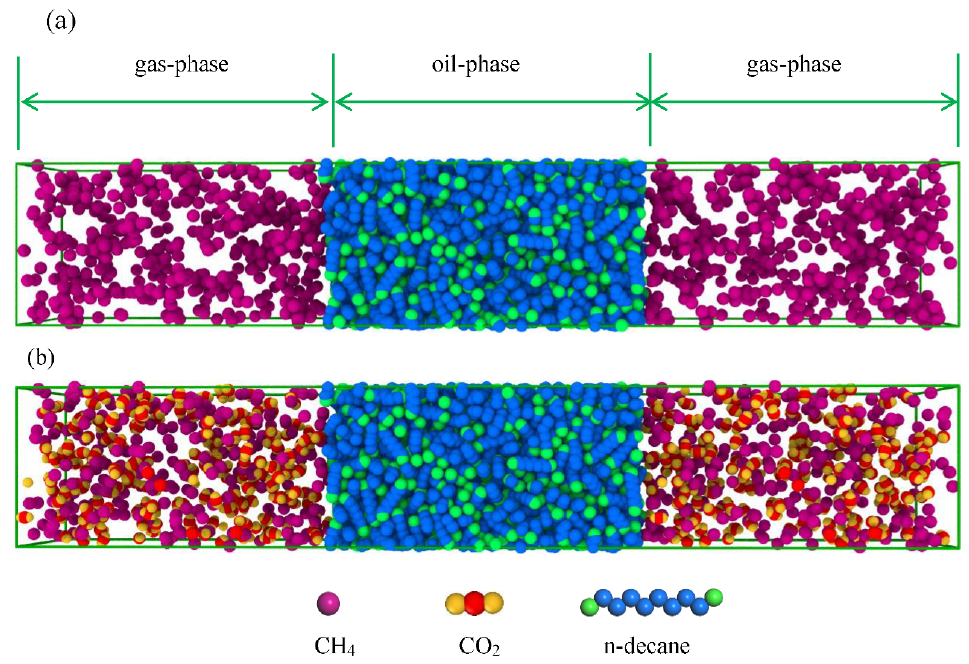
Figure 1. Gas–oil phase simulation systems: ( a ) CH 4 + n-decane binary mixture system, ( b ) CH 4 + CO 2 + n-decane ternary mixed system. CO 2 + n-decane ternary mixed